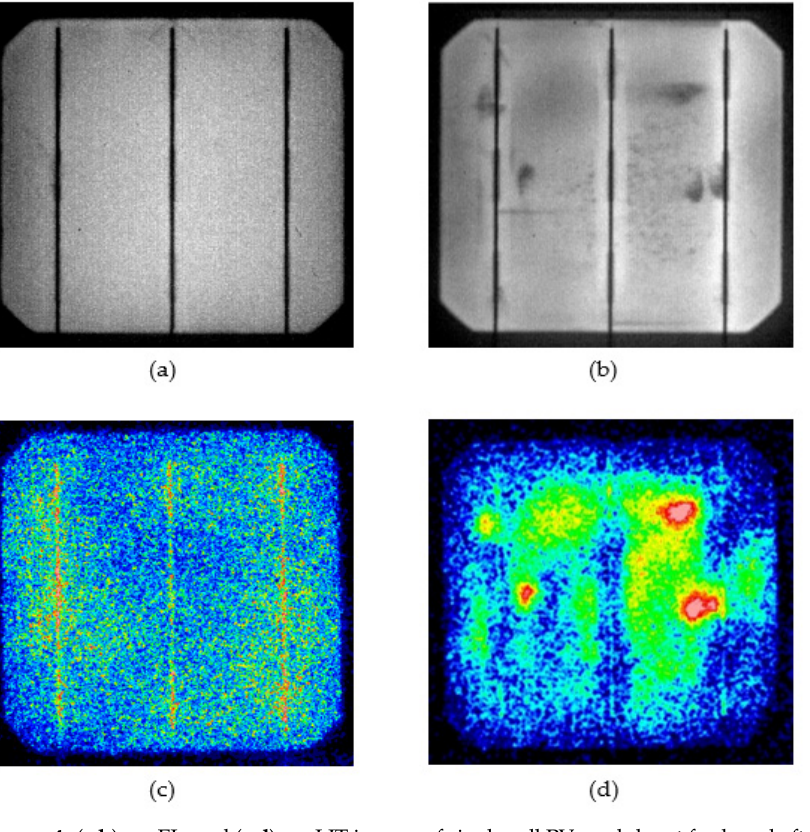
Figure 4. ( a , b ) are EL, and ( c , d ) are LIT images of single-cell PV modules at fresh and after PID stress test.